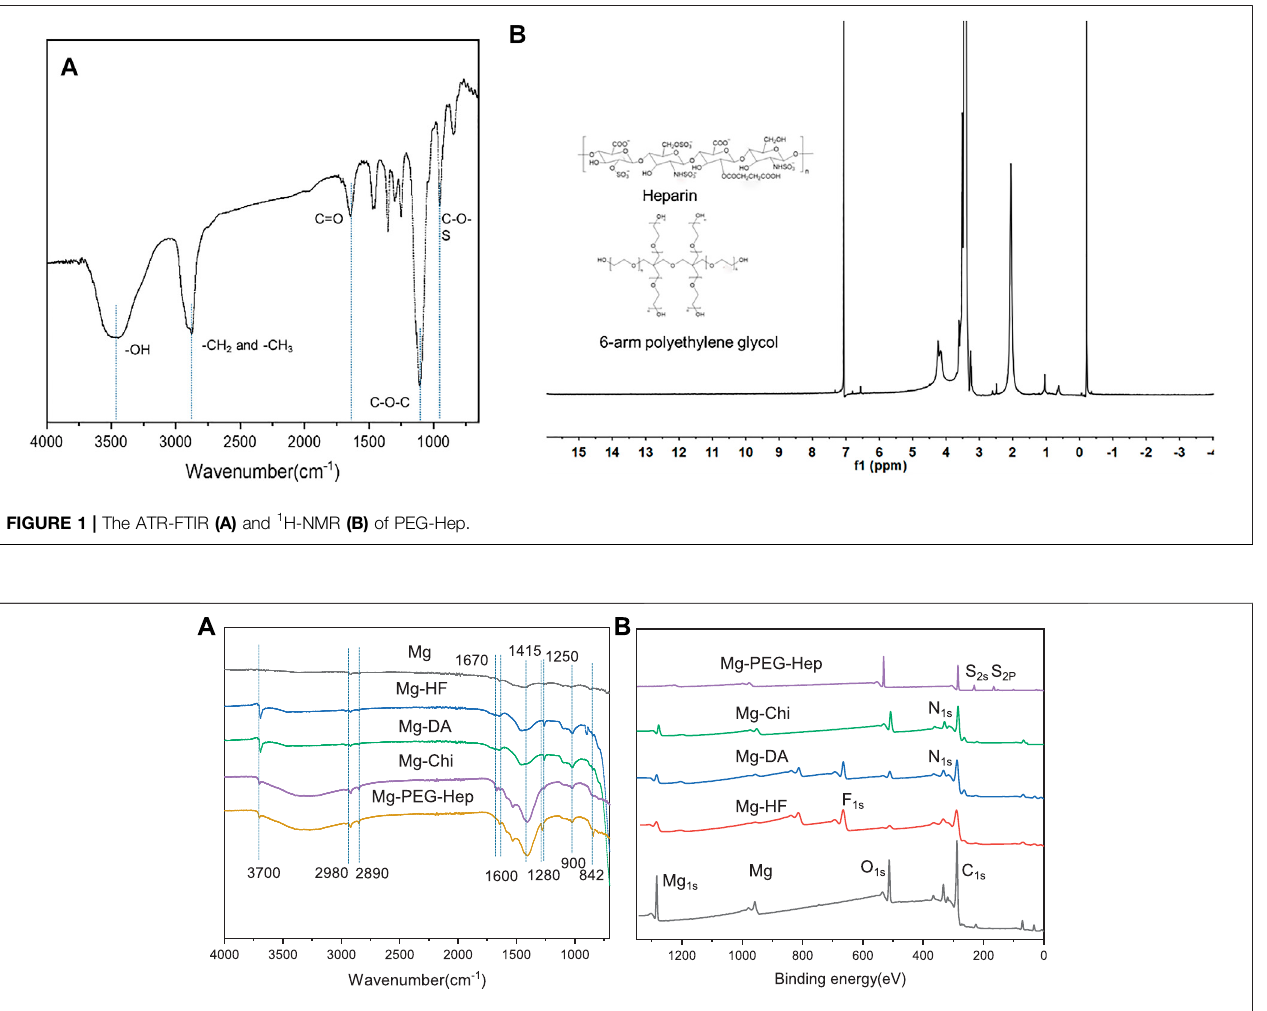
FIGURE 2 | The ATR-FTIR (A) and XPS (B) spectra of the different samples.